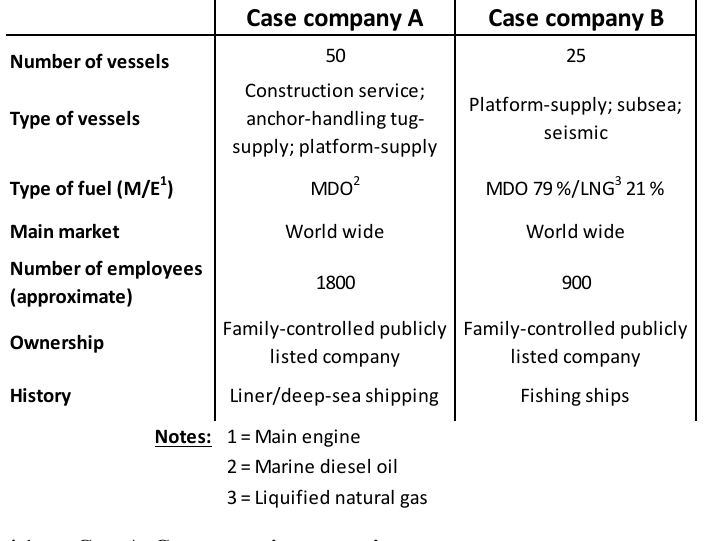
Table 1 . Comparative firm characteristics (2016)